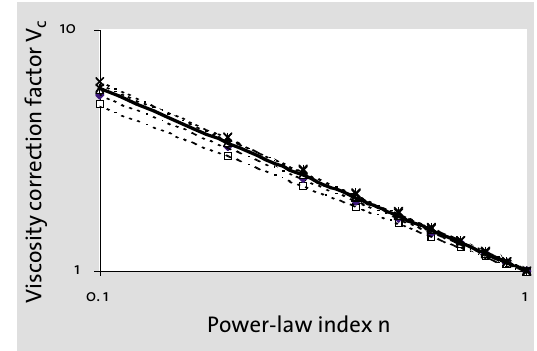
Figure 17 (left above): Con- sistency and power-law index relationship for 45 dif- ferent European fabric con- ditioners [16]. Figure 18 (right above): Vis- cosity correction factor, Vc, as a function of power-law index, n, for Brookfield spin- dles RV2 – 6 respectively, (points and dotted lines), together with the simple function Vc = n-0.75 shown as a solid, bold line. RV2 data is the lowest curve, progressing upwards to RV6, the highest. Figure 19 (left below): A schematic representation of viscosity versus shear rate (logarithmic axes) showing typical day-to-day varia- tions of a non-Newtonian liquid product. Solid lines slow equivalent Newtonian viscosities and shear rates, while dashed lines show the actual curves. The ‘mean’ product is represented by the heavy lines. The lines ending in arrows fl repre- sent the variations at one particular spindle speed for the Newtonian assumption (vertical line) or the real vis- cosity/shear-rate points obtained using a non-New- tonian analysis (curves line ending in